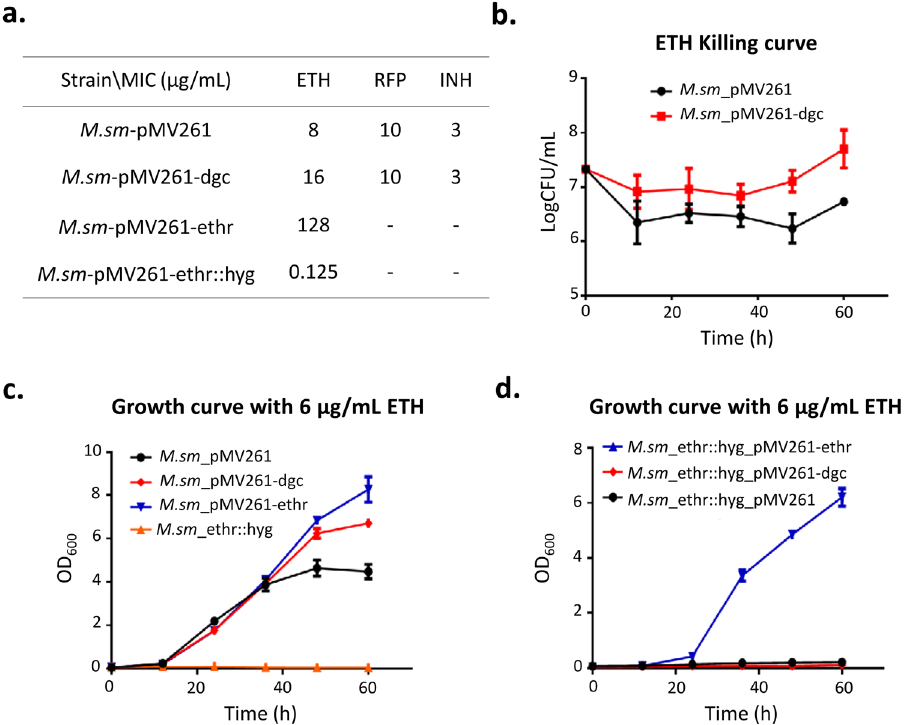
Figure 3. c-di-GMP increases M.sm resistance to ETH. ( a ). Antibioctic sensitive assay for the effects of c-di- GMP on different antibiotics. Different strains grew in serially diluted (128–0.125 μ g/mL) antibiotics, i.e . ethionamide (ETH), rifampicin (RFP), or isoniazidea (INH). MIC represent the lowest concentration of drug under which strains can grow. ( b ). Time-Kill curve for M.sm during 60 h. The curve is depicted by the growth of M.sm -pMV261 and M.sm -pMV261-dgc under 120 μ g/mL ETH at interval of 12 h. The concetration of ETH chosed is 15-fold MIC of M.sm -pMV261. ( c , d ). Growth curve for M.sm under 6 μ g/mL during 60 h. The curves are depicted by the growth of M.sm -pMV261, M.sm -pMV261-dgc, M.sm -pMV261-ethr, and M.sm -ethr::hyg under 6 μ g/mL ETH at interval of 12 h ( c ) and by the growth of M.sm -ethr::hyg-pMV261, M.sm -ethr::hyg- pMV261-dgc, M.sm -ethr::hyg-pMV261-ethr under 6 μ g/mL ETH at interval of 12 h ( d ). Means ± standard deviation (S.D.) represent the variant range of the data derived from three biological